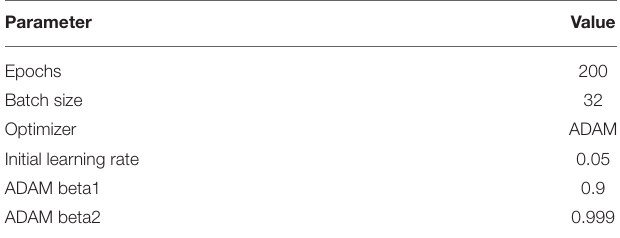
TABLE 1 | Training parameters of the vision